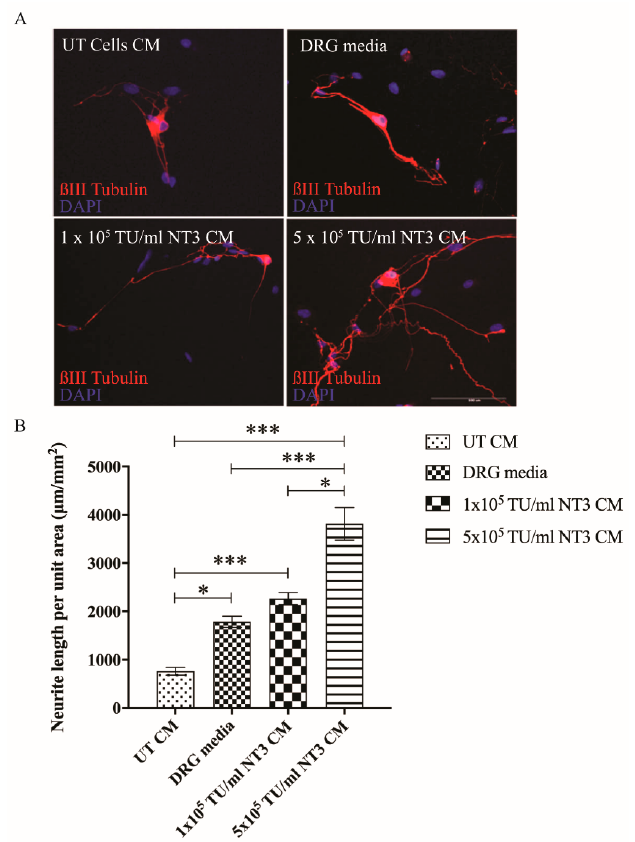
Figure 2. NT-3 produced from 293T transduced cells promotes neurite outgrowth in vitro. Photomicrographs show representative images of projected confocal images of dorsal root ganglia (DRG) neurons after treatment with media from untransduced cells (UT), DRG media (positive control), media from 293T cells transduced with 1 × 10 5 TU / mL or 5 × 10 5 TU / mL of NT-3 lentiviral vector ( A ). Scale bar = 200 µ m. Graph shows the neurite length per unit area measured using stereology. Significance compared to untransduced cell media is shown ( B ). Data shown as mean neurite length per unit area ± SEM. * p ≤ 0.05, ** p ≤ 0.01, *** p ≤ 0.001. n = 3. Tukey’s post-hoc test using one-way ANOVA.